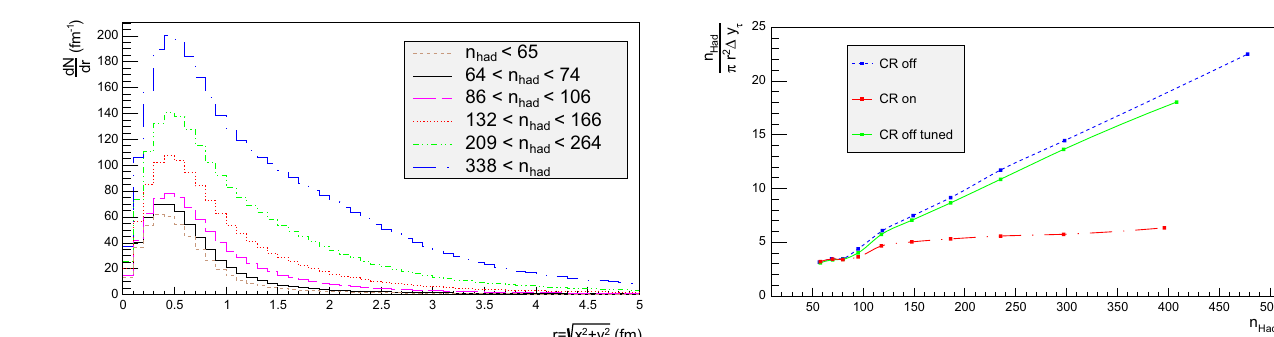
Fig. 26 Hadron density as a function of multiplicity for pp collisions at 13 TeV. The red, blue and green curves represent the three different models with and without colour reconnection, also included in Fig.